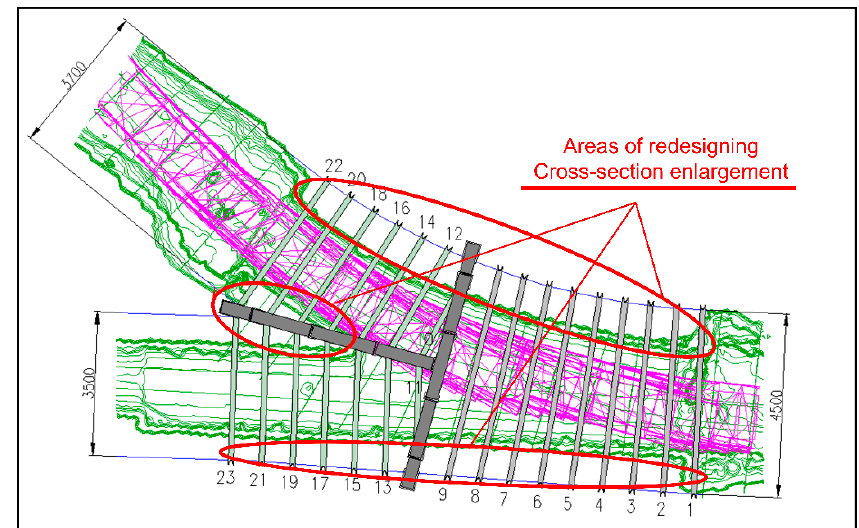
Figure 18. The outline of the working planned for reconstruction, planned portal lining and areas of redesigning.